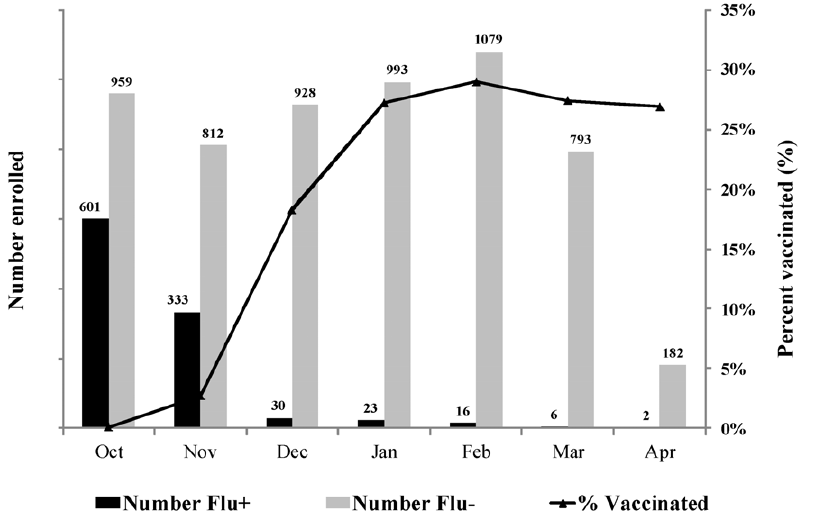
Figure 1. Number of influenza-positive cases and influenza-negative controls enrolled in the Flu-VE study by month of illness onset, October 2009 through April 2010, and percent vaccinated greater . 14 days prior to illness onset. (Vaccination rates were , 1% in October).